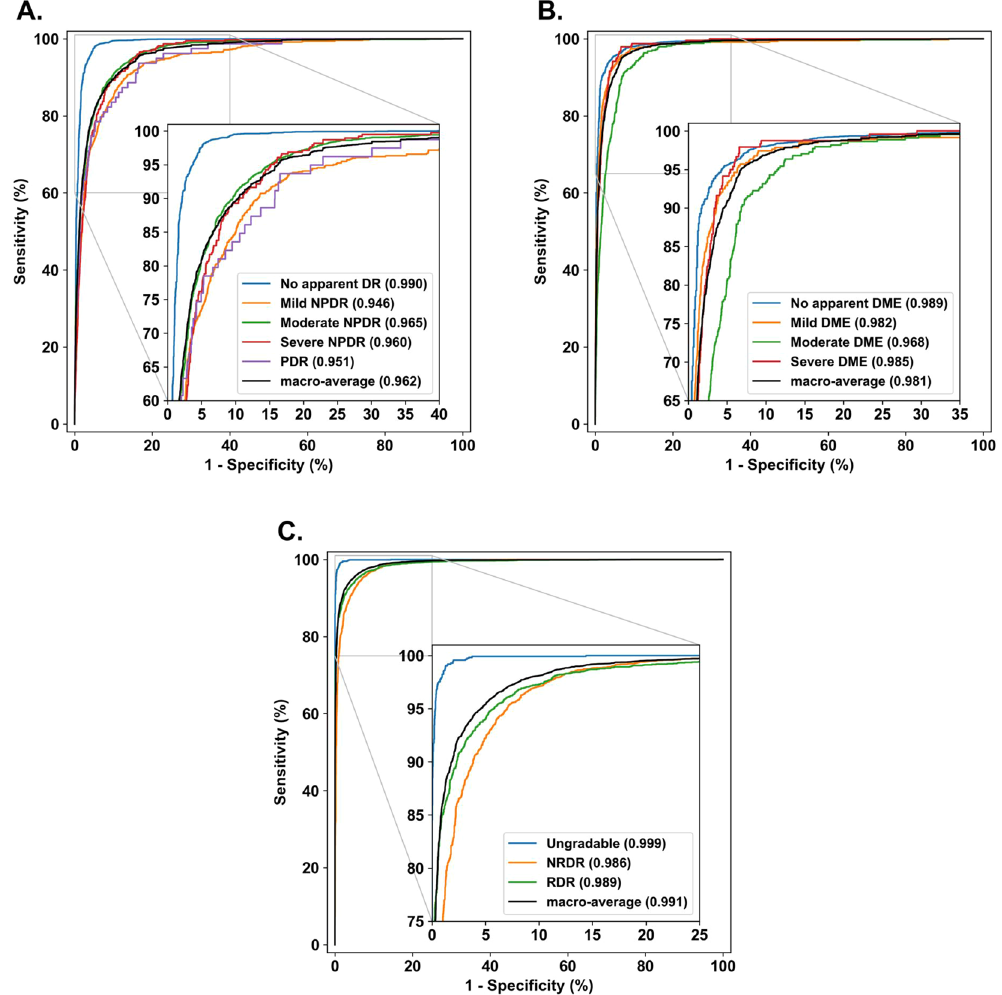
on the primary validation set (N = 7304) with input size 2095 × 2095. ( C) QRDR classification on the primary validation set (N = 8226) with input size 1024 × 1024. Multiclass tasks include PIRC, PIMEC and QRDR for the best performing models based on macro-AUC. ROC curves are shown for each class in one-vs-all strategy with addition of macro-average of ROC. Positive class marked in legend with AUC shown in